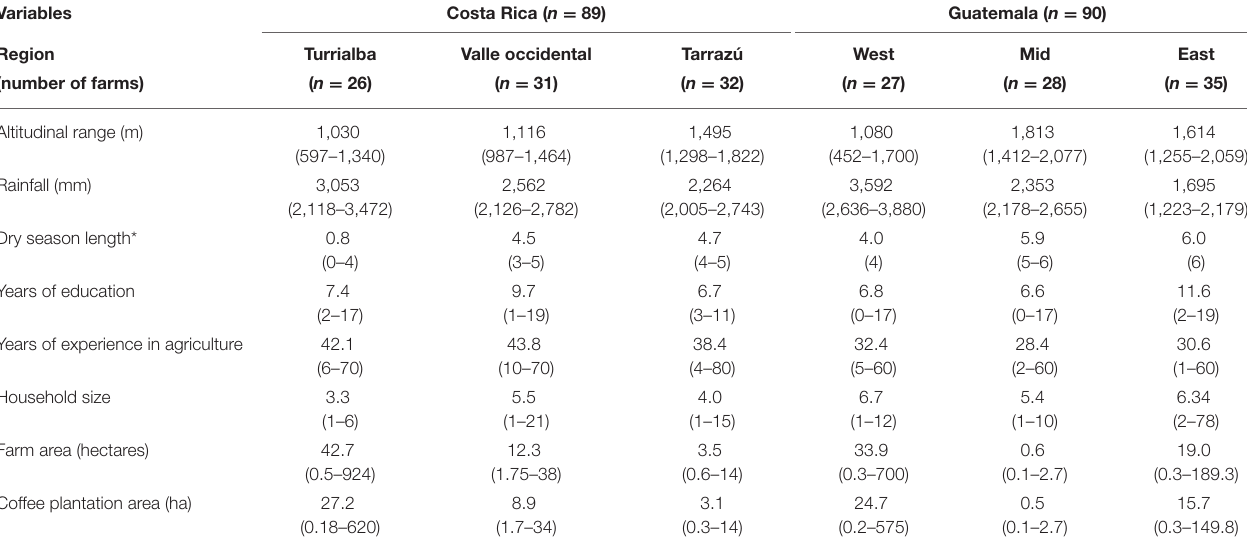
TABLE 1 | Characterization of the farms in Costa Rica and Guatemala considered in the study (values are means, with range in parentheses). Variables Costa Rica ( n = 89) Guatemala ( n = 90) Region Turrialba Valle occidental Tarrazú West Mid East (number of farms) Altitudinal range